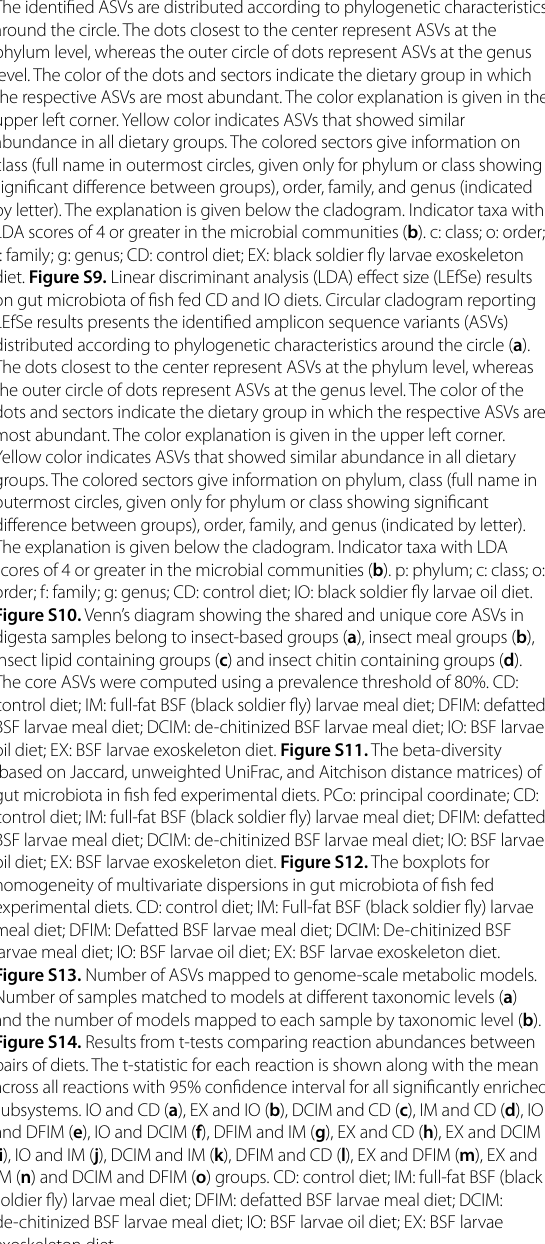
Additional file 2: Table S1 . Chemical composition (%, as is) of meals and fractions of black soldier fly (BSF) larvae. Table S2. Fatty acid composition (% of total fatty acids) of the lipid fraction of black soldier fly larvae. Table S4 . Pair-wise comparison of alpha diversity indices of gut microbiota in fish fed experimental diets containing meals and fractions of black soldier fly (BSF) larvae – adjusted p values. Table S5. PERMANOVA analysis for beta-diversity of gut microbiota in fish fed experimental diets containing meals and fractions of black soldier fly (BSF) larvae – adjusted p value. Table S6. Test of homogeneity of multivariate dispersions among dietary